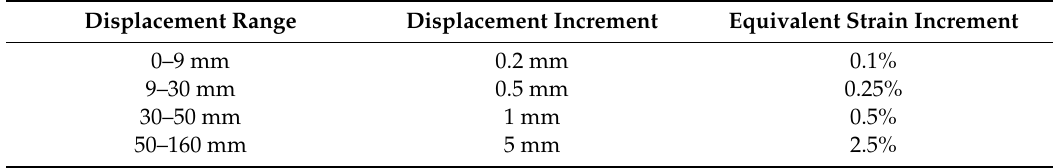
Table 2. Specified increments for optical time domain reflectometry (OTDR) testing.